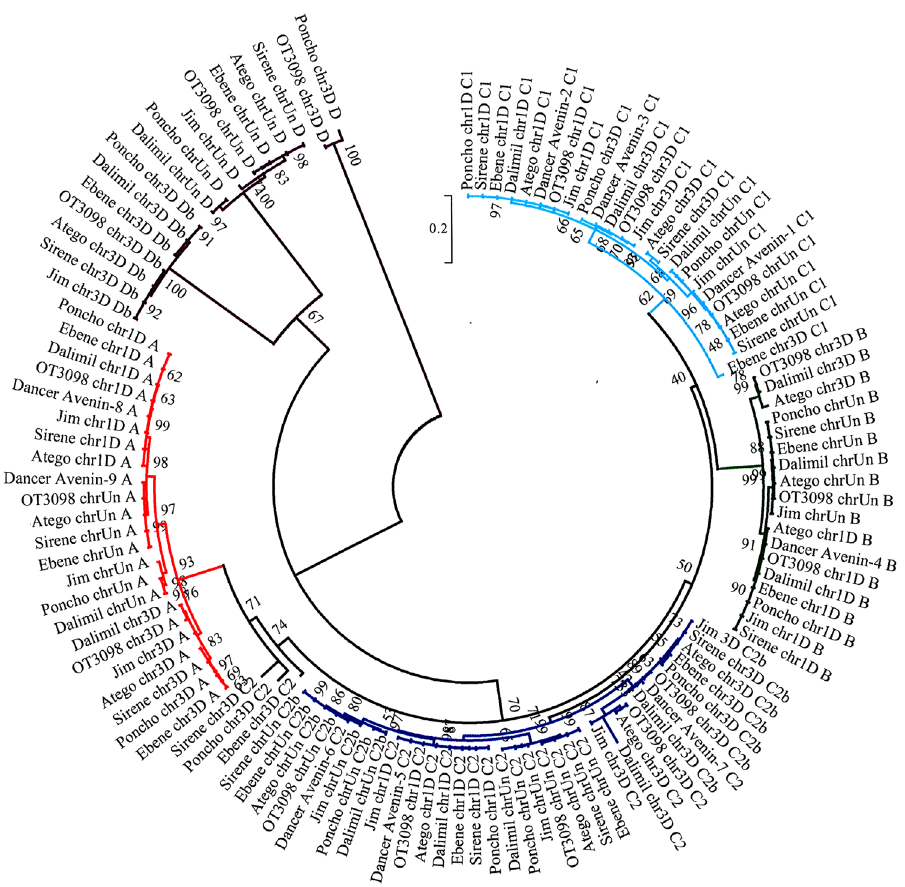
Figure 2. Molecular Phylogenetic analysis of avenins by Maximum Likelihood method based on the Jukes- Cantor model. The tree with the highest log likelihood (− 19412.94) is shown. The analysis involved 119 nucleotide sequences; there were a total of 1043 positions in the final dataset. Colours of branches correspond to the group of avenins: red—avenin (A); green—avenin (B); light blue—avenin (C1); dark blue—avenin (C2); violet—avenin